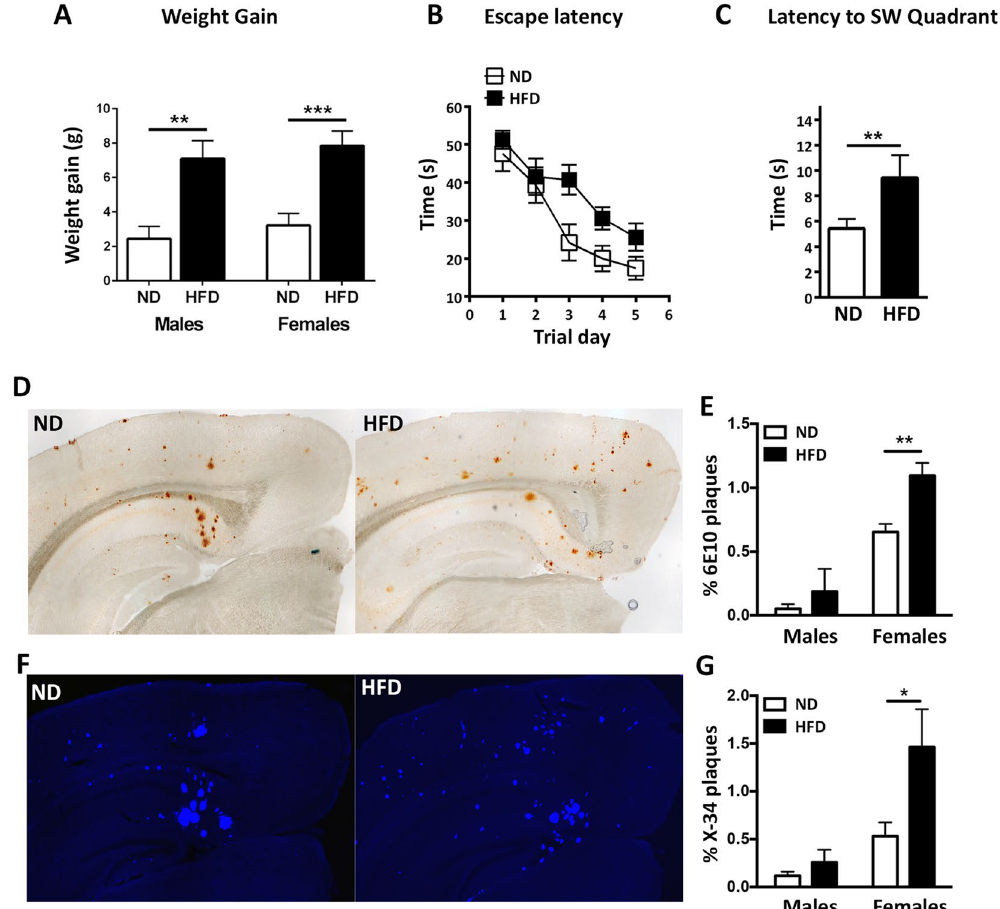
N = 9–11 males, 13–14 females per group. ** p < 0.01; *** p < 0.001. ( B ) Acquisition trial of MWM (Escape latency). Statistic by two-way ANOVA. No interaction between trial day and diet; significant main effect of diet (F (1,110) = 11.24, p = 0.0011) and trial day (F (4,110) = 12.38, p < 0.0001). ( C ) Probe trial of MWM (latency to the target). Student’s t -test. ( B , C ) N = 5–7 mice gender/group. ( D–G ) Amyloid plaques in cortex and hippocampus of APP23 mice on ND and HFD were analyzed by two-way ANOVA followed by Sidak’s multiple comparison test. Representative images ( D ) and quantification ( E ) of A β deposits (6E10 staining). No interaction between diet and gender and significant effect of diet (F (1,12) = 29.92, p = 0.0001) and gender (F (1,12) = 40.58, p = 0.0001). On the graph is shown the result of Sidak’s post-hoc test. Representative images ( F ) and quantitation ( G ) of X-34 fibrillary amyloid plaques. No interaction and significant main effect of diet (F (1,12) = 5.32, p = 0.004) and gender (F (1,12) = 12.11, p = 0.003). On the graph is shown the result of Sidak’s post-hoc test. For D-G N = 4–5 male, 5 female mice per group. * p < 0.05 and ** p <